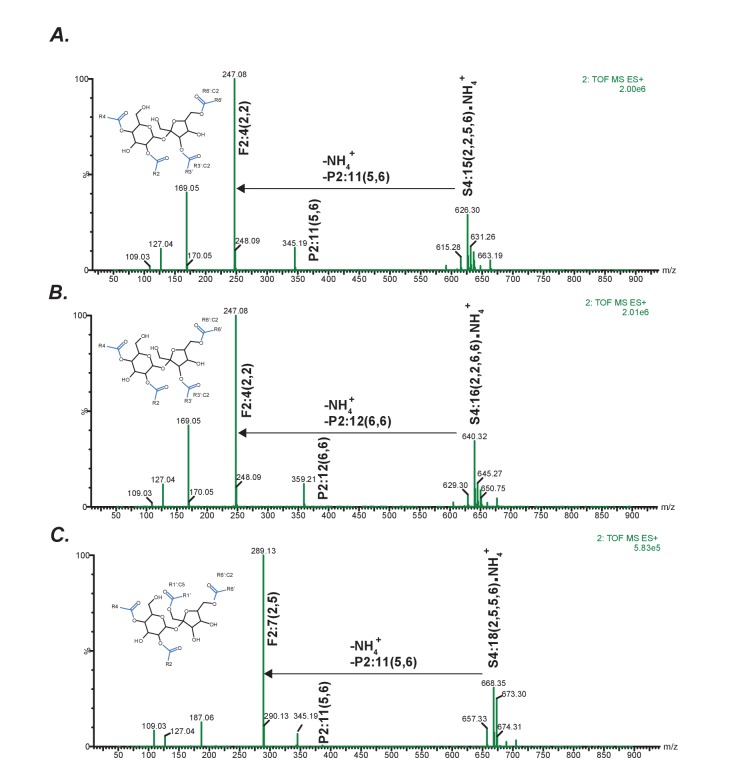
Positive mode fragmentation patterns of novel acylsugars found in SsASAT3 VIGS knockdown plants.In (A,B,C), mass spectra obtained at elevated collision energies of three different novel acylsucrose peaks are shown. We make the assumption that fragment ions and the most abundant pseudomolecular ions appearing at the same retention time are associated. In all three cases, assuming that the original mono- and di-acylations occurred on the pyranose (P) ring, we can infer that the subsequent C2 and C5 additions giving rise to the tri- and tetra-acylated sugars occurred on the furanose (F) ring.